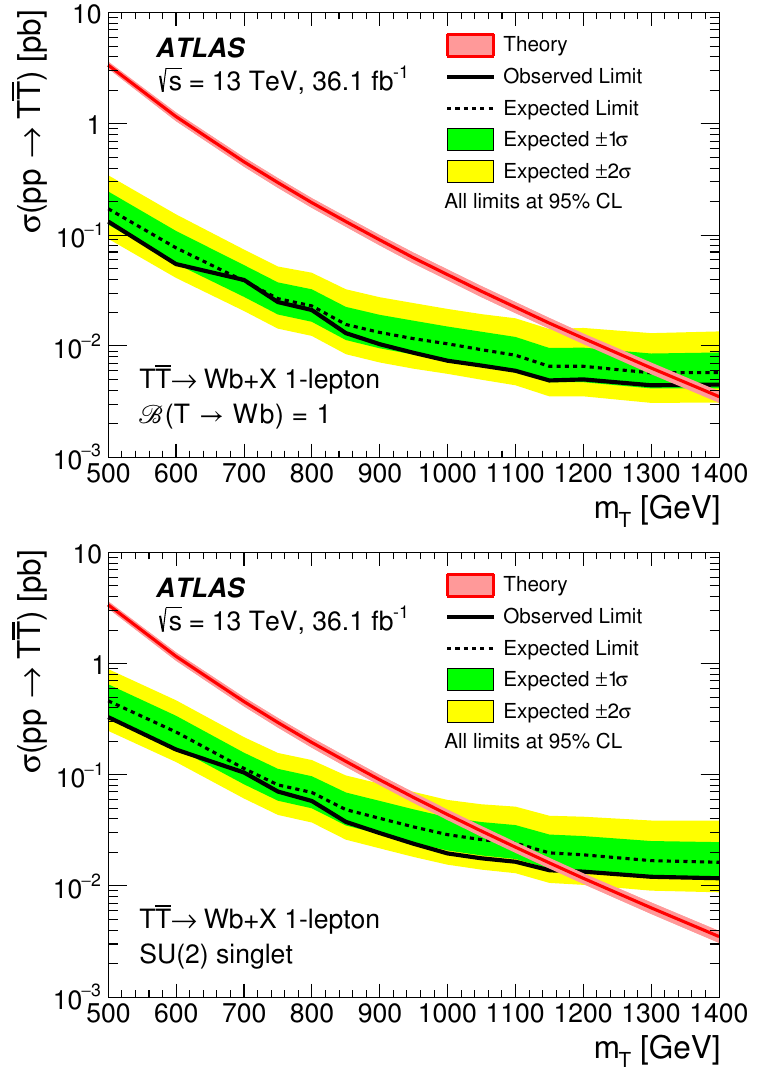
Figure 4 . Expected (dashed black line) and observed (solid black line) upper limits at the 95% CL on the T (cid:22) T cross-section as a function of T quark mass assuming B ( T ! Wb ) = 1 (top) and in the SU(2) singlet T scenario (bottom). The green and yellow bands correspond to (cid:6) 1 and (cid:6) 2 standard deviations around the expected limit. The thin red line and band show the theoretical prediction and its (cid:6) 1 standard deviation